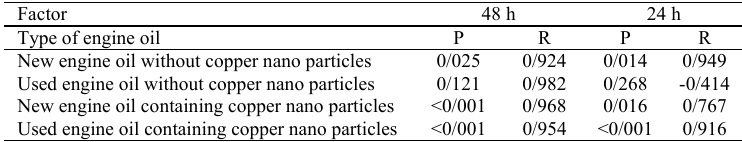
Table 2. Correlation between lethality and increasing concentration in paper test at 24 and 48 h